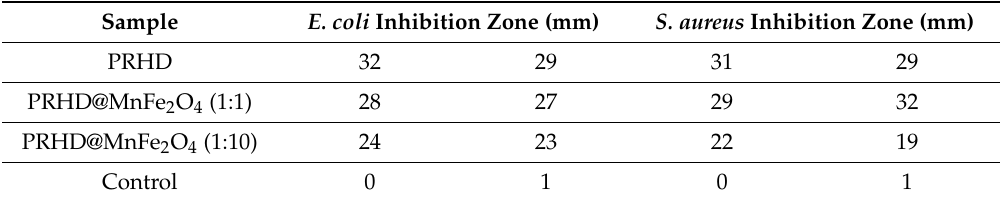
Table 2. Antibacterial activity of PRHD@MnFe 2 O 4 hybrids against pathogenic bacteria (inhibition of growth expressed as the diameter of inhibition zone).